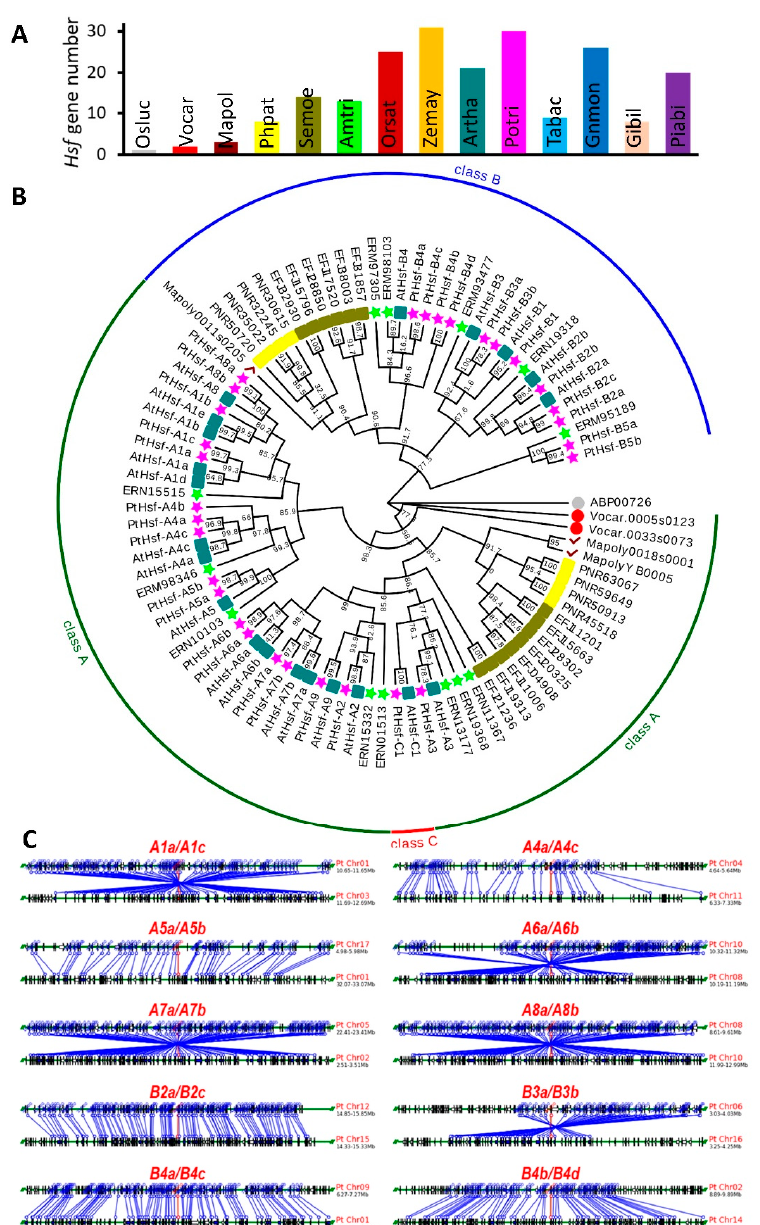
Figure 1. The Hsf gene family underwent gene expansion in evolution history. ( A ) The gene number of Hsf genes in different plants. Note that the Hsf gene number was multiplied from algae to land plants. Ostreococcus lucimarinus ( Osluc ), Volvox carteri ( Vocar ), Marchantia polymorpha ( Mapol ), Physcomitrella patens ( Phpat ), Selaginella moellendorffii ( Semoe ), Amborella trichopoda ( Amtri ), Arabidopsis thaliana ( Artha ), Populus trichocarpa ( Potri ), Oryza sativa ( Orsat ), Zea mays ( Zemay ), Gnetum montanum ( Gnmon ), Taxus baccata ( Tabac ), Ginkgo biloba ( Gibil ) and Picea abies ( Piabi ). ( B ) Evolutionary relationship of the Hsfs from Osluc , Vocar , Mapol , Phpat , Semoe , Amtri , Artha and Potri . Note that every subfamily Hsf genes in Arabidopsis and poplar were expanded from Amborella trichopoda , the oldest angiosperm. ( C ) Syntenic relationships of duplicated genes in the PtHsf family.